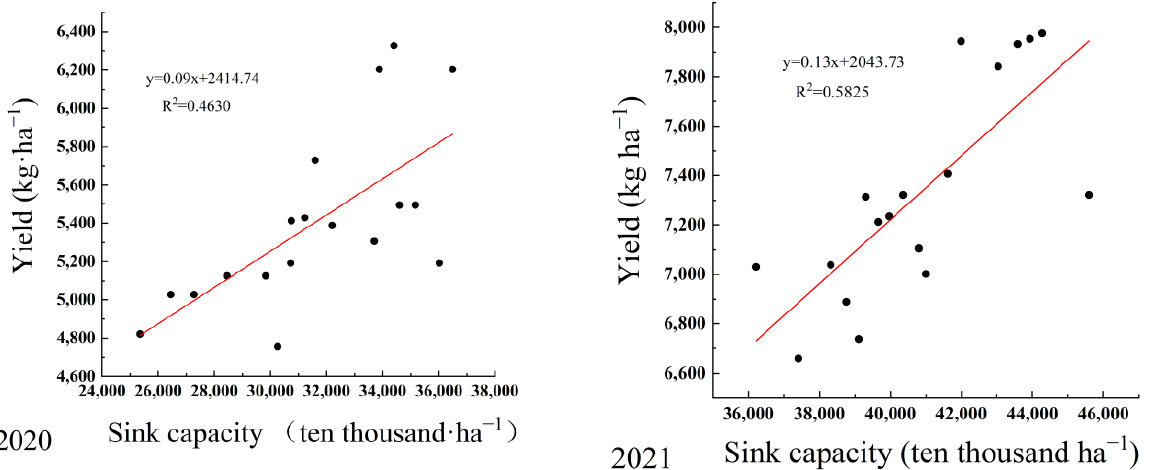
Figure 3. Relationship between sink capacity and grain yield of rice in 2020 and 2021.